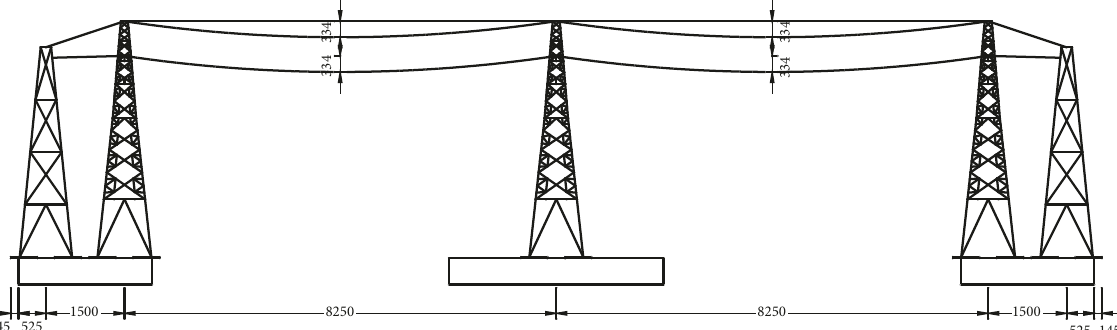
Figure 9: Elevation of the five-tower-four-line